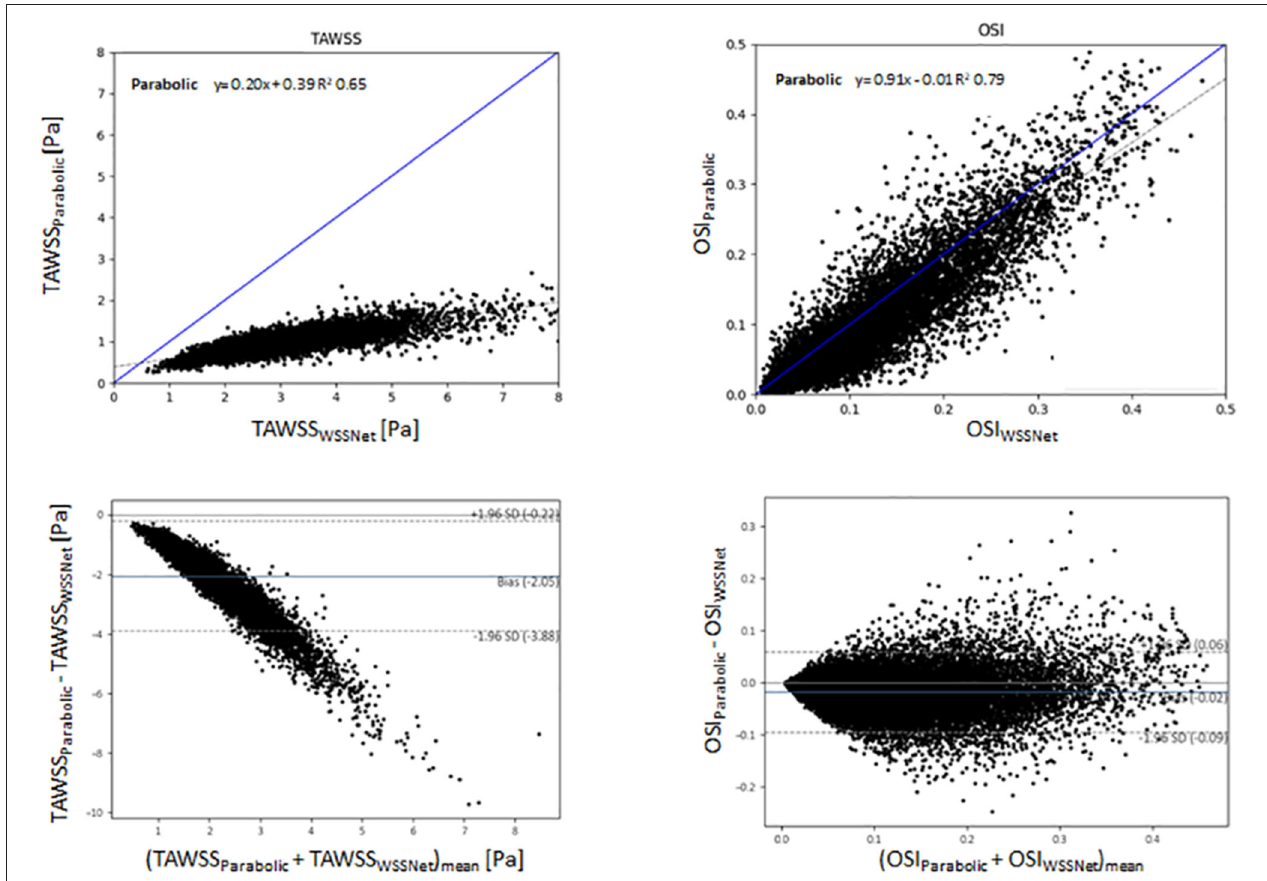
FIGURE 11 | Top: Linear regression comparing the TAWSS and OSI derived from the estimation of WSSNet and parabolic fitting method from in vivo 4D Flow MRI. WSSNet estimates are used as the reference values. Bottom: Bland-Altman plots of TAWSS and OSI between the parabolic fitting method and WSSNet for in vivo cases (n = 43). The plots show 5% of the data points, randomly selected.